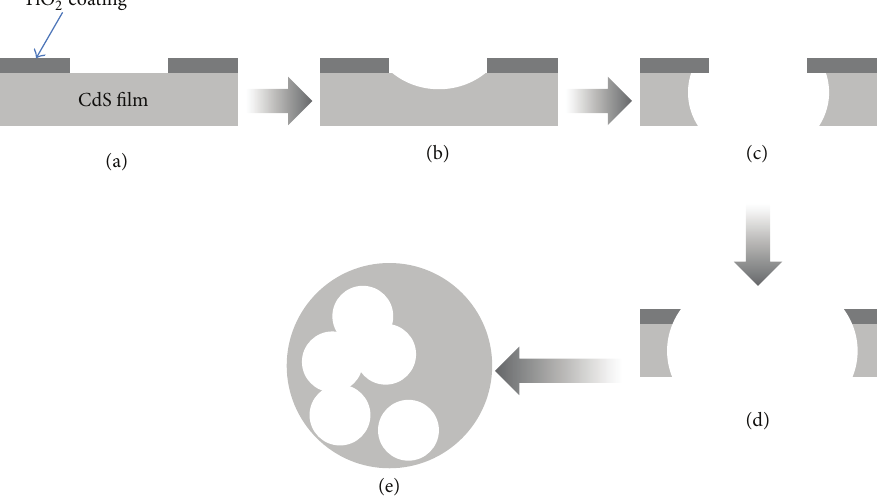
Figure 5: Schematic view of the corrosion mechanism where the corrosion starts with the presence of pinhole or crack in the pristine sample (a) at which the corrosion is initiated (b). The corrosion then expands in all directions until the substrate underneath the CdS is reached (c), after which the corrosion pit expands in lateral direction (d) until it merges with one or more neighboring corrosion pits (e).